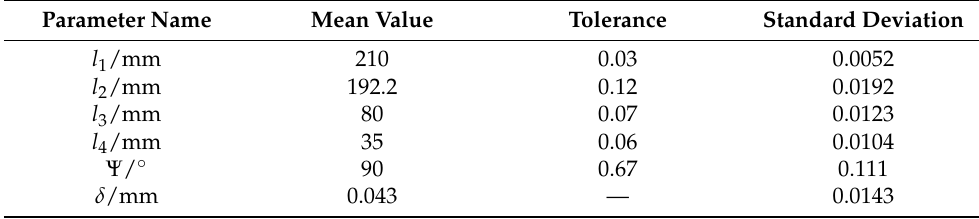
Table 1. Parameters related to each rod.